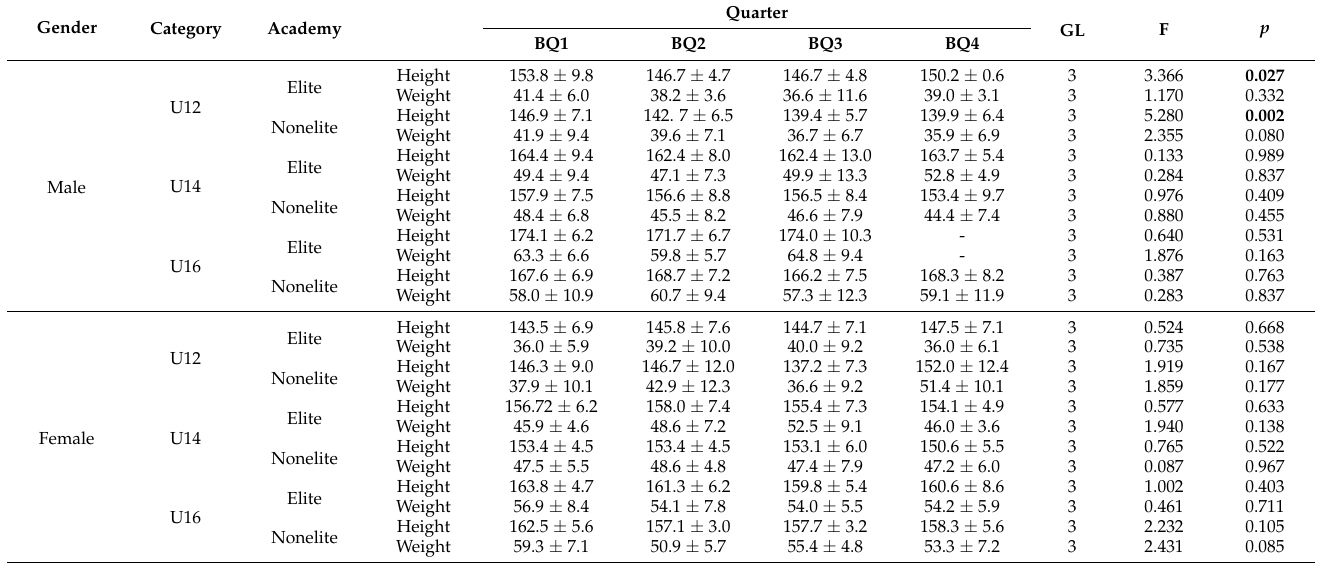
Table 3. Anthropometric and RAE in all categories.